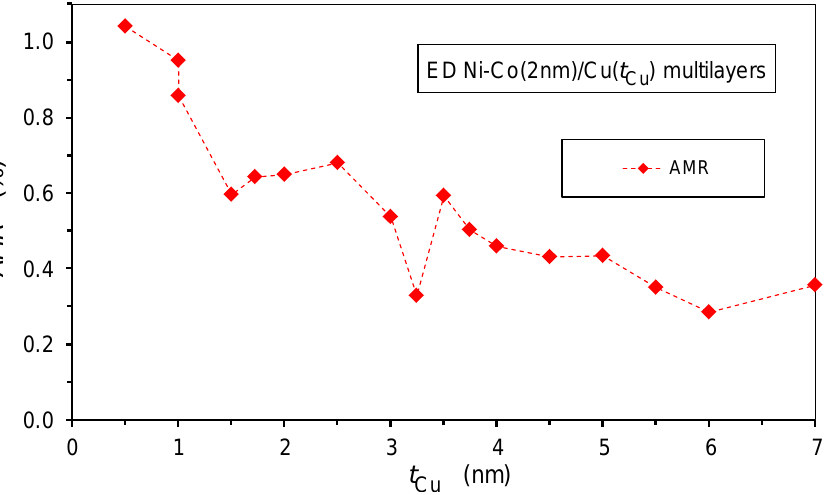
Figure 14. Evolution of the AMR ratio with spacer layer thickness t Cu for the present Ni65Co35/Cu multilayers.